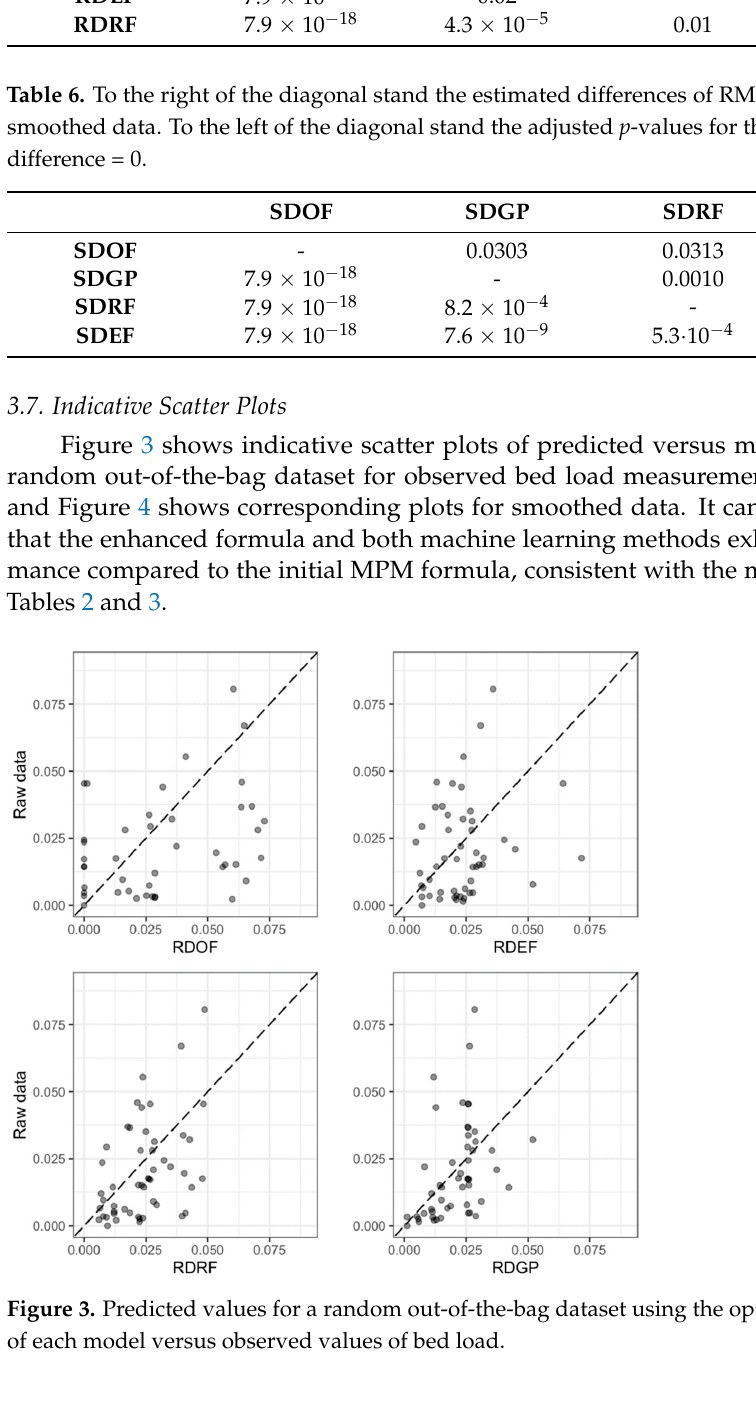
Figure 4. Predicted values for a random out-of-the-bag dataset using the optimal tuned parameters of each model versus smoothed values of bed load.